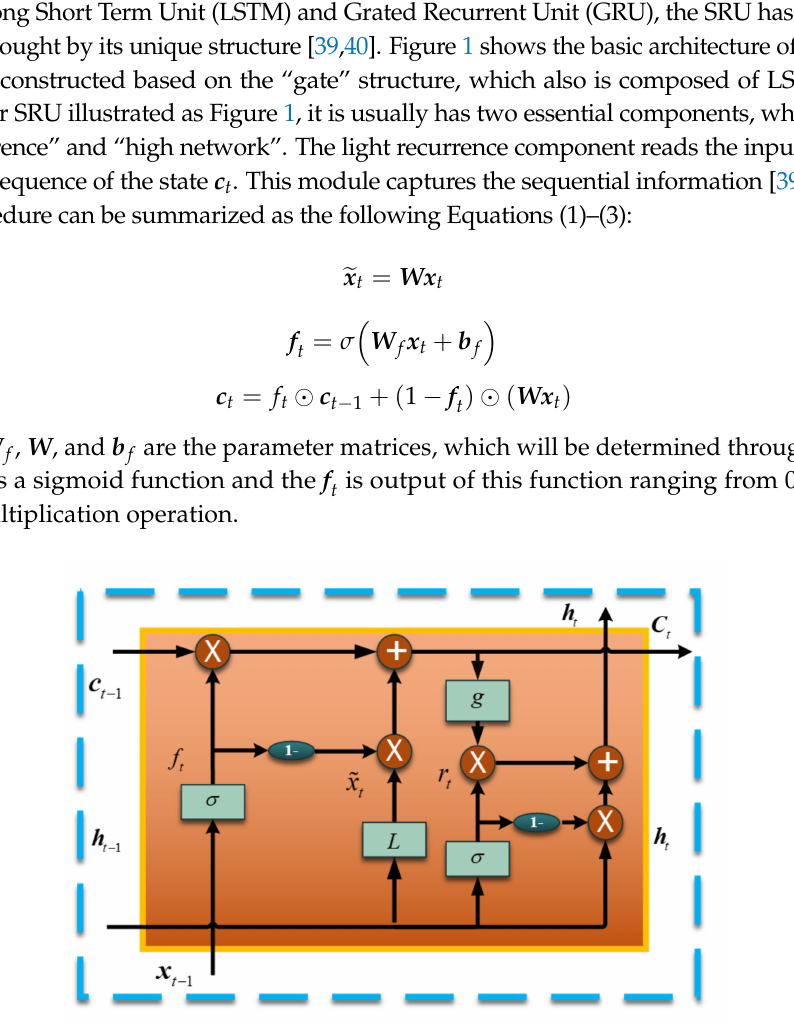
Figure 1. Basic structure of the Simple Recurrent Unit (SRU) Working